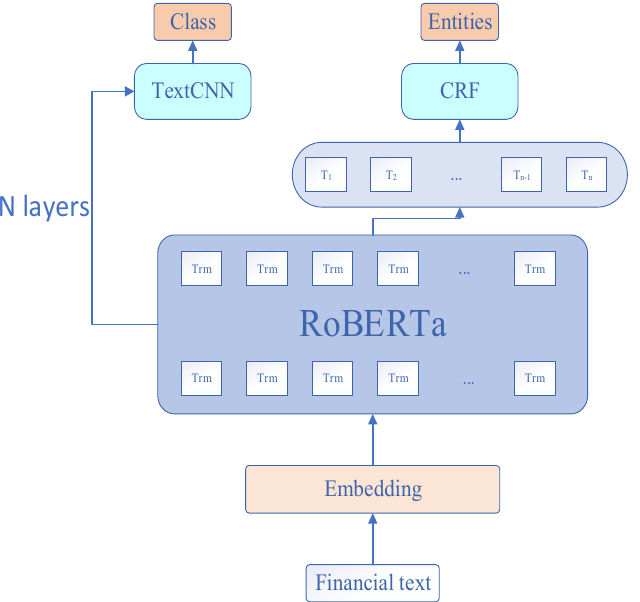
Figure 1. Joint extraction model framework for financial product opinion and entities.